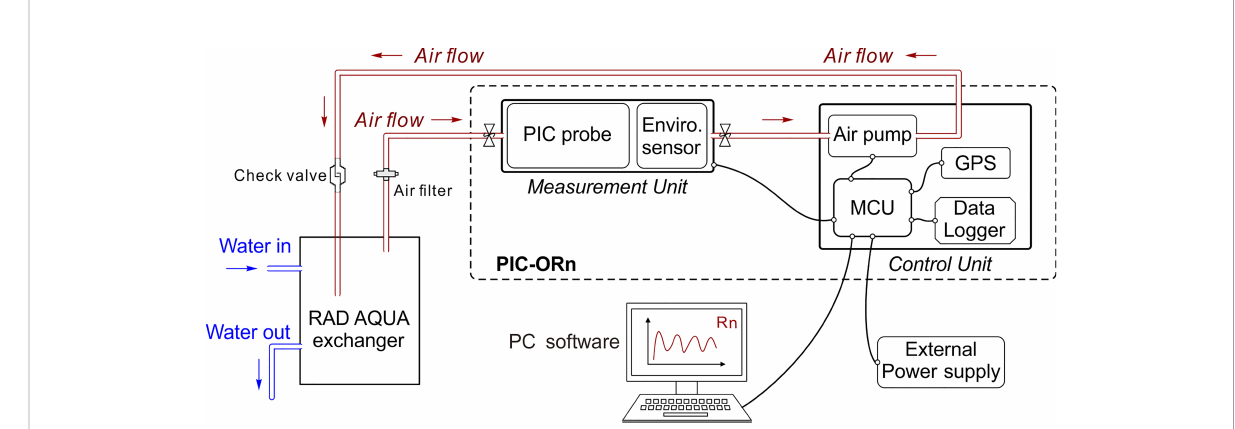
FIGURE 1 Schematic diagram of an automated radon measurement system for continuous measurements of radon-in-water. Everything inside the dotted lines is the PIC-ORn detector, which consists of the measurement and control units. Equilibrated air from the RAD AQUA exchanger is directed to the measurement unit via a diaphragm air pump. Every ten minutes or other manually set-up interval, the combined information including radon activity, temperature, humidity, pressure, and GPS locations are stored in the data logger and/or transmitted from the microcontroller unit (MCU) inside the PIC-ORn detector to a self-programed PC software. One can download all the data afterwards if a computer is not readily available on fi eld